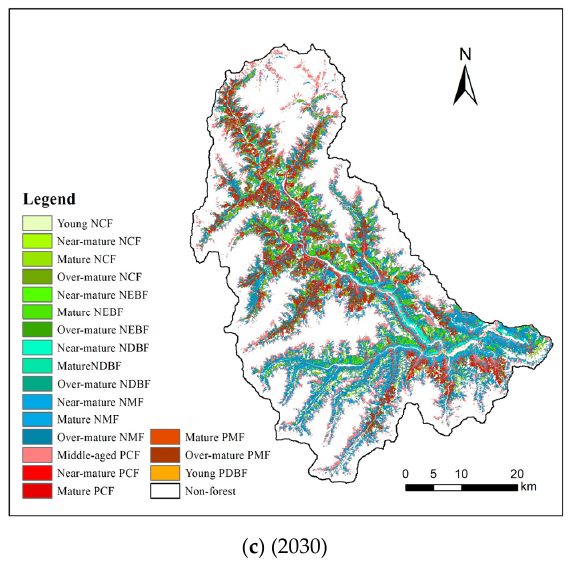
Figure 7. Forest change prediction under artificial restoration scenarios in 2010, 2020 and 2030.